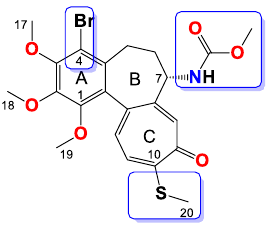
Figure 6. Structure of compound 6